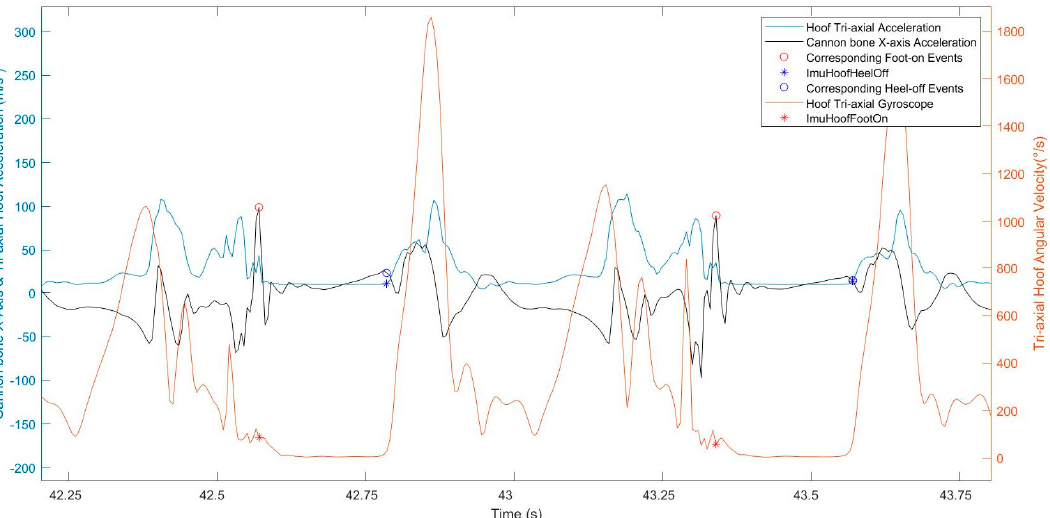
Figure 3. Representation of the normalized signals of the hoof tri-axial acceleration (blue curve), the hoof tri-axial gyroscope (red curve), and the cannon bone x -axis acceleration (black curve) of a horse trotting in a straight line on soft ground. The red stars correspond to the reference foot-on; the blue stars correspond to the reference heel-off. The cannon bone x -axis acceleration at these same events also appears on the cannon bone curve (blue and red circles on the yellow curve).